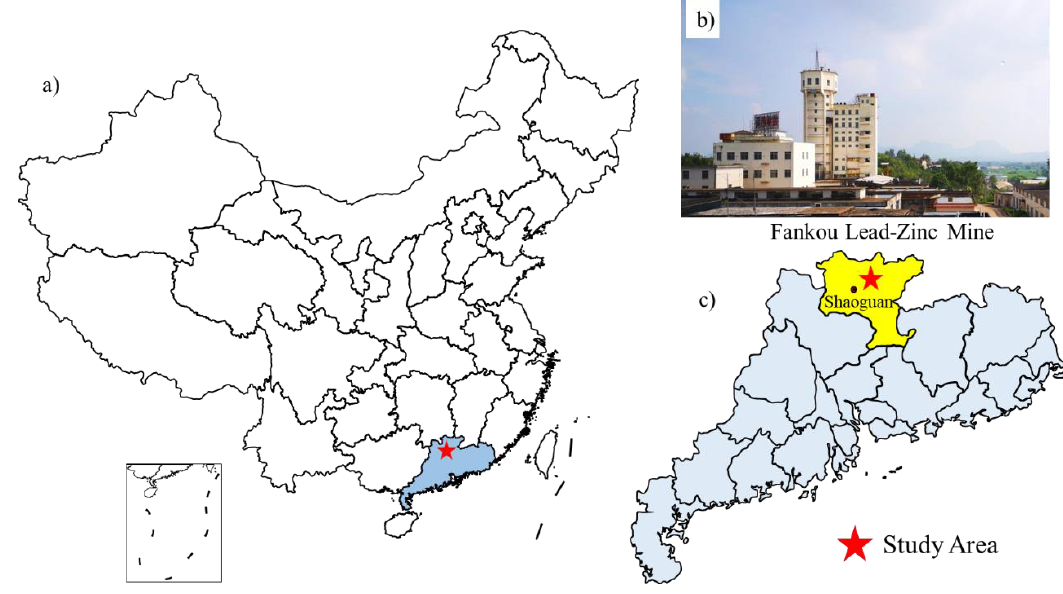
Figure 1. Fankou Lead-Zinc Mine. ( a ) Mine’s position in China; ( b ) a view of the mine; ( c ) mine’s position in Guangdong province.